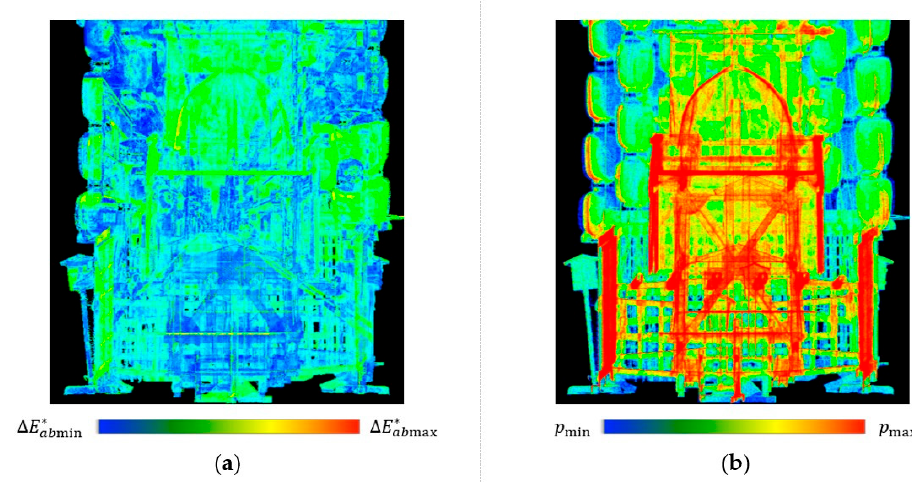
Figure 4. Visualization of ( a ) the color di ff erence between the point cloud and the background and ( b ) number of projected